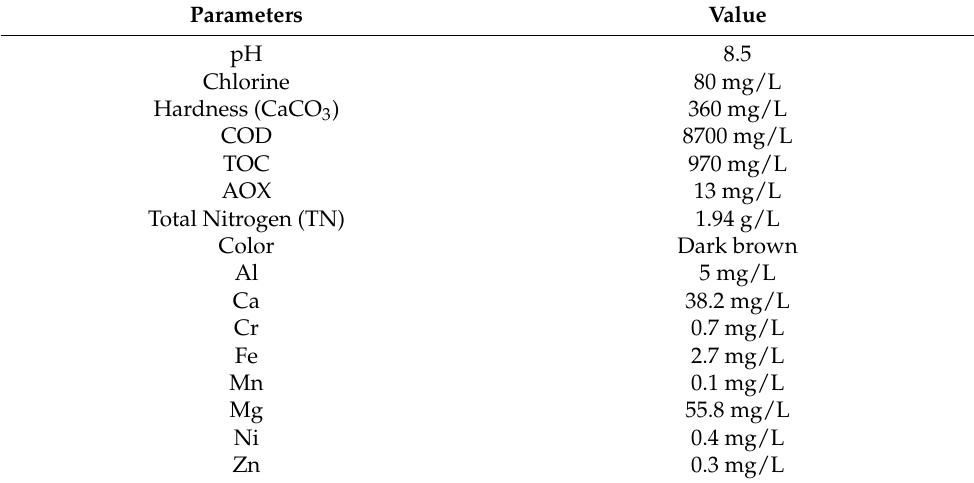
Table 1. Characteristics of landfill